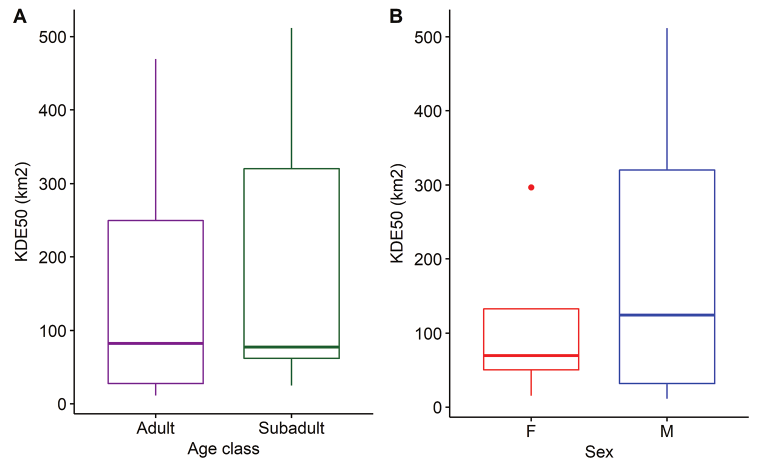
Figure 3. Core area size by age class ( A ) and sex ( B ) in Eastern Romanian Carpathians and Subcarpathians (box = interquartile range, horizontal line = median, whiskers = 1.5 × interquartile range, points =